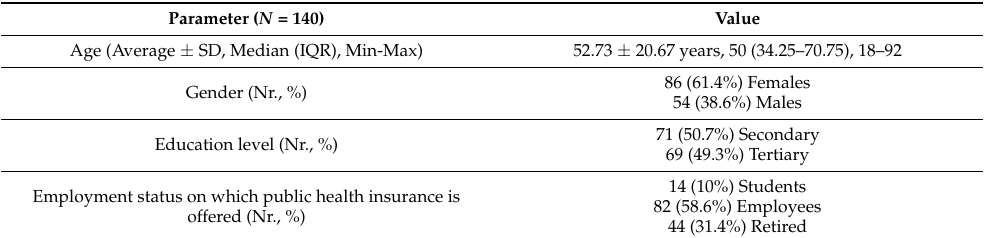
Table 1. Demographic characteristics of the analyzed